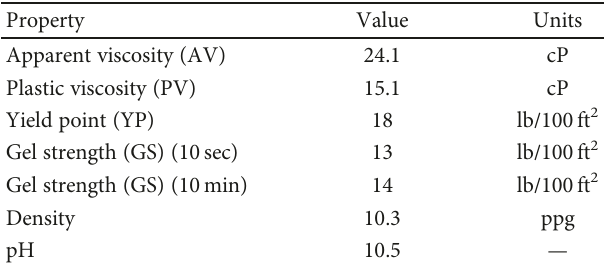
Table 3: Drilling fl uid